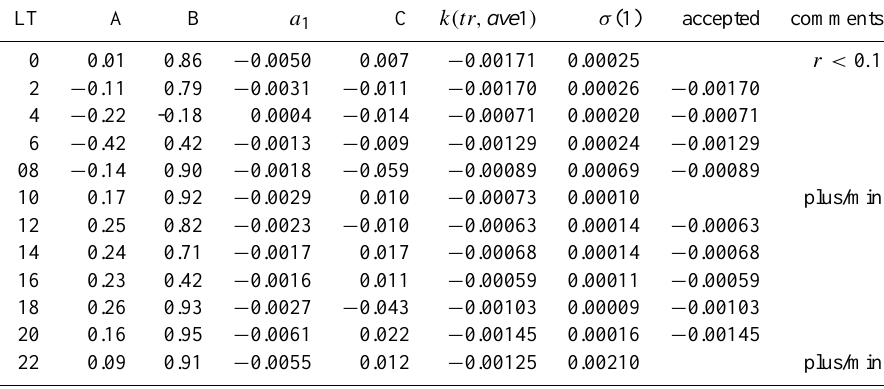
Table 2. Calculation of the trends for the Tashkent